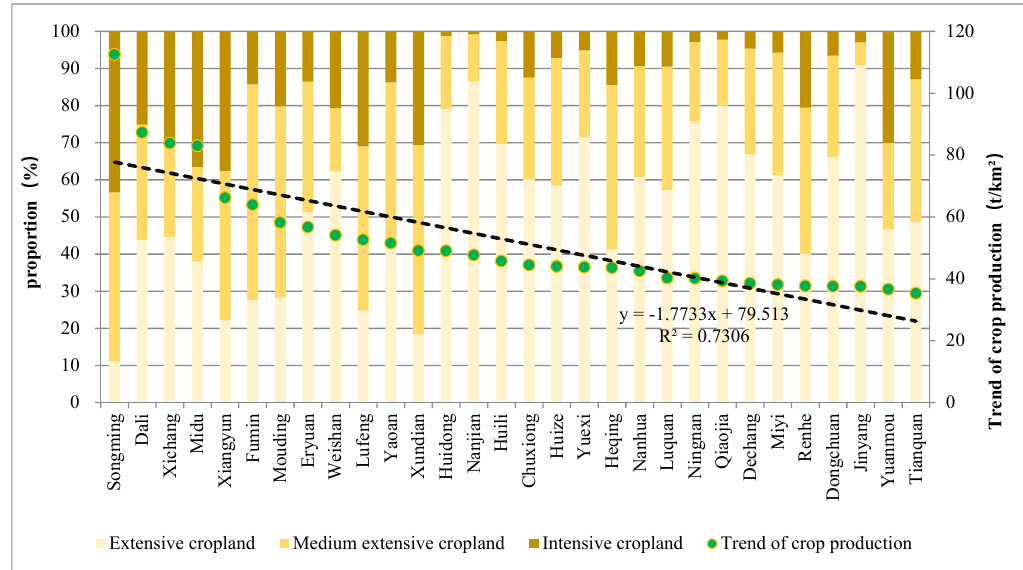
Figure 8. Validation of results of cropland classification. The histogram represents the ratios of different types in the cropland system; the green dots show total crop production at the county level, and the black dotted line shows the results of linear fitting.